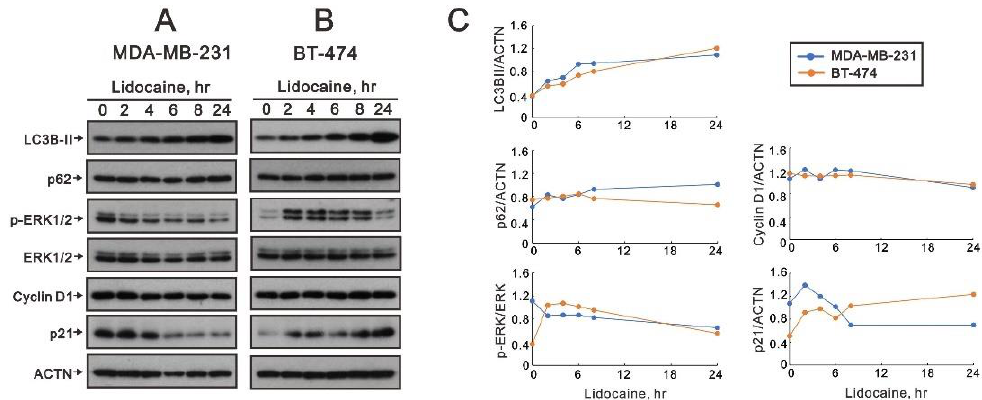
Figure 11. The effects of lidocaine on cell signaling regulation in MDA-MB-231 and BT-474 cells. ( A ) MDA-MB-231 and ( B ) BT-474 (3 × 10 5 ) cells were treated with 2.5 mM of lidocaine for the indicated time points. The cell lysates were subjected to Western blotting analysis using antibodies against the indicated proteins. ACTN was used as the protein loading control. ( C ) The protein bands ( A , B ) were quantified through pixel density scanning and evaluated using ImageJ, version 1.44a (http://imagej.nih.gov/ij/) (accessed on 1 November 2022). The ratios of protein/ACTN and pERK/ERK were